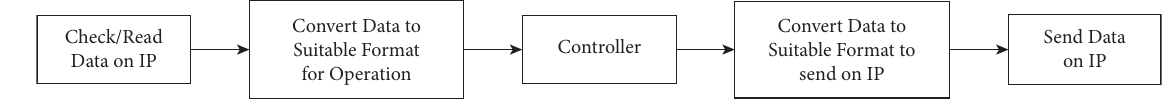
Figure 7: Block diagram for PIL simulation in simulator. Table 4: Gains from PIL